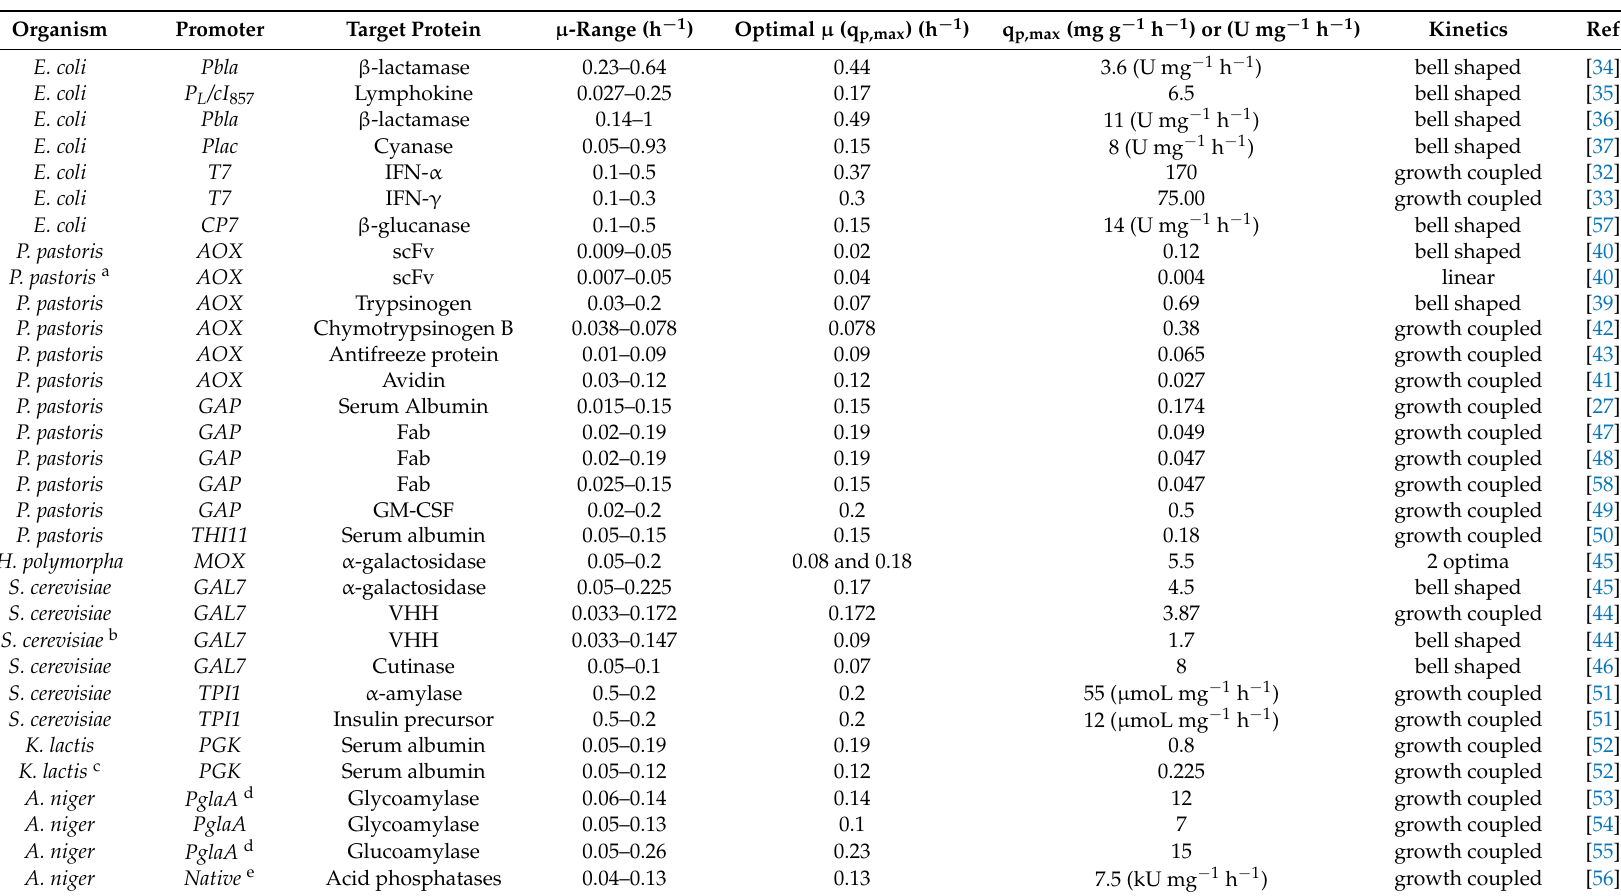
Table 1. µ -dependent product formation kinetics in continuous cultures. Abbreviations used: IFN: interferon; scFv: Single-Chain Variable Fragment Antibody; GM-CSF: granulocyte- macrophage colony stimulating factor; VHH: variable domain of heavy chain